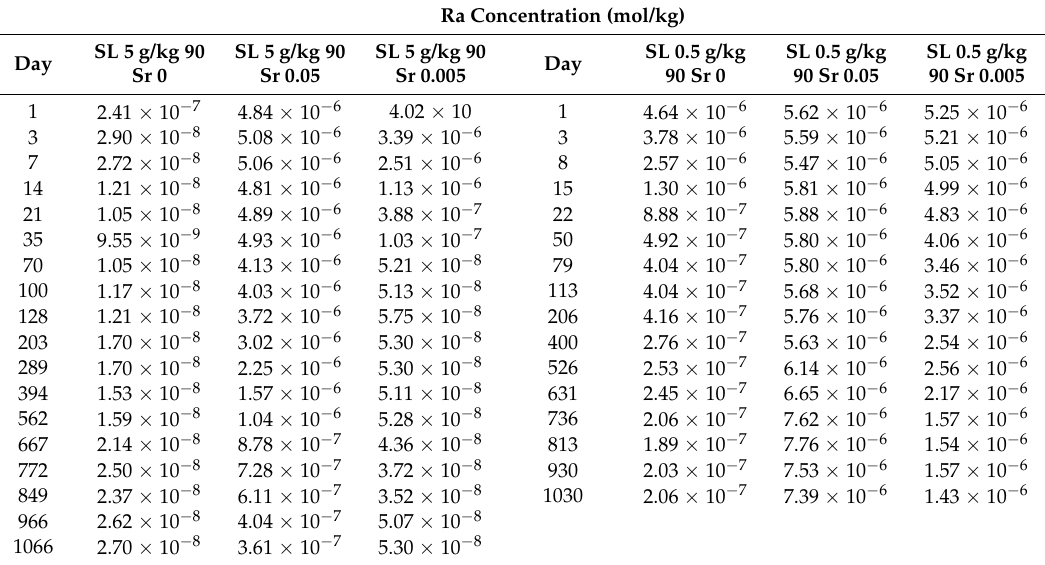
Table A5. Ra concentration of experiments with Sr in the aqueous solution at 90 ◦